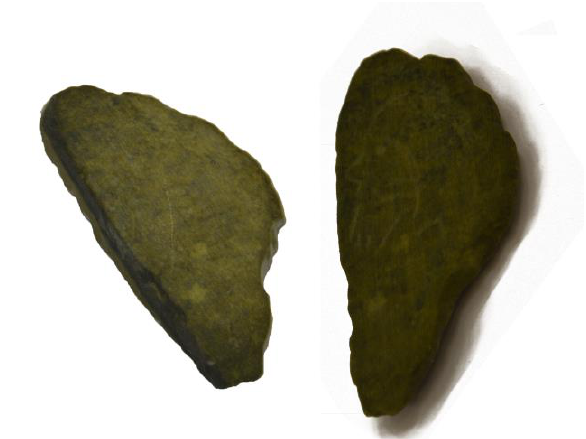
Figure 8: Comparison between the coloured 3D replica and the “augmented”